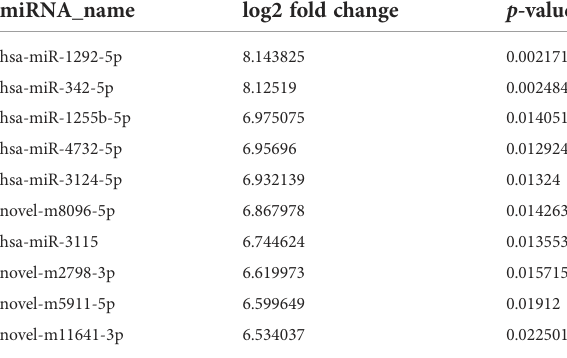
TABLE 2 The top 10 upregulated miRNAs between cholangiocarcinoma and control samples.